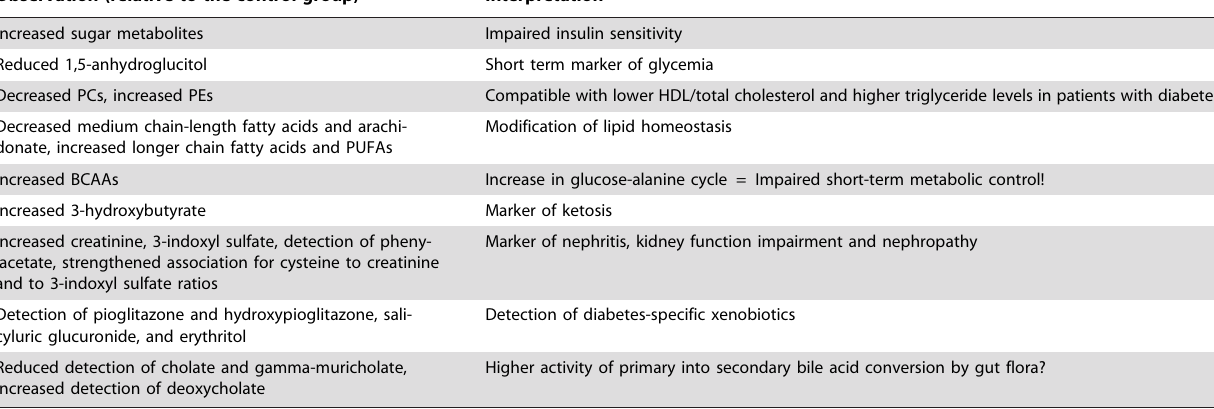
Table 6. Overview of